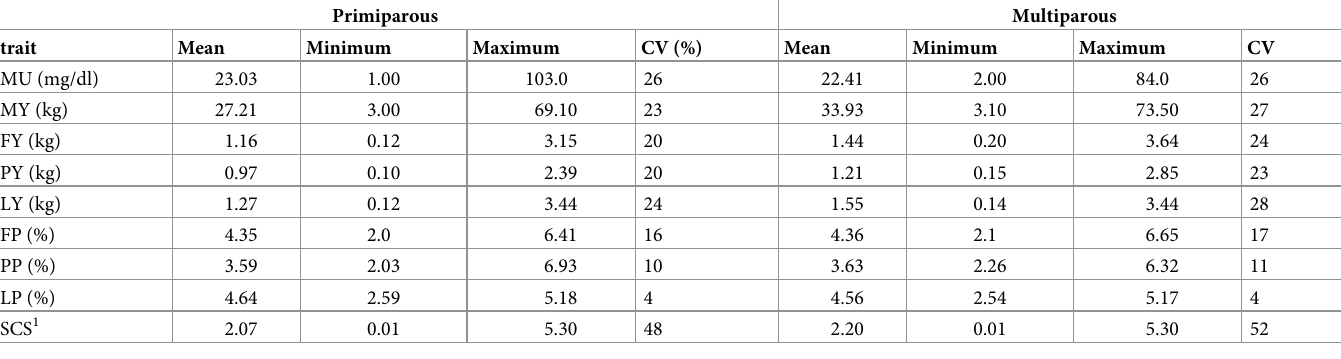
Table 1. Mean, minimum, maximum, and CV for MU, and milk production traits in primiparous (n = 51,345 test-day records on 7,850 lactations) and multiparous (n = 39,249 test-day records on 4,358 lactations) cows. Primiparous Multiparous